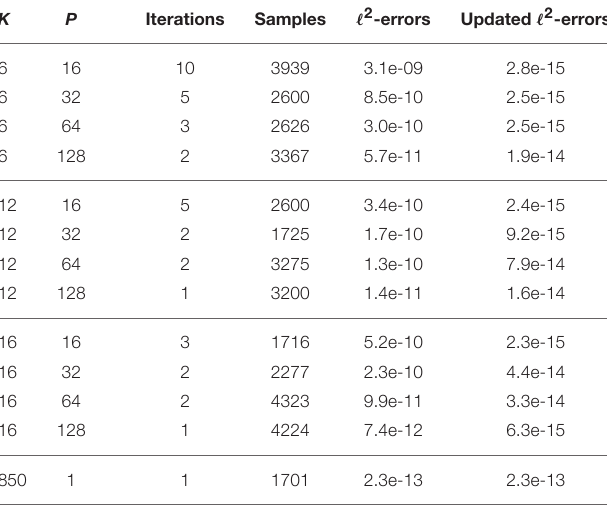
TABLE 5 | Results for Algorithm 3.2 via MUSIC for frequency grid parameter S = 2 16 and sparsity M = 256 with random coefficients on the unit